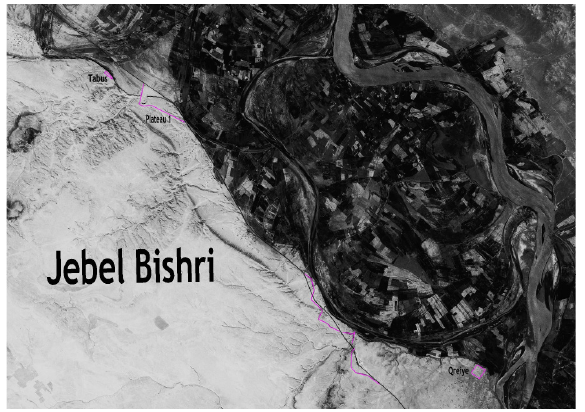
Figure 10. An ancient road alignment detected on a CORONA photograph along the Euphrates between the Late Roman forts of Tab ū s and Qreiye.